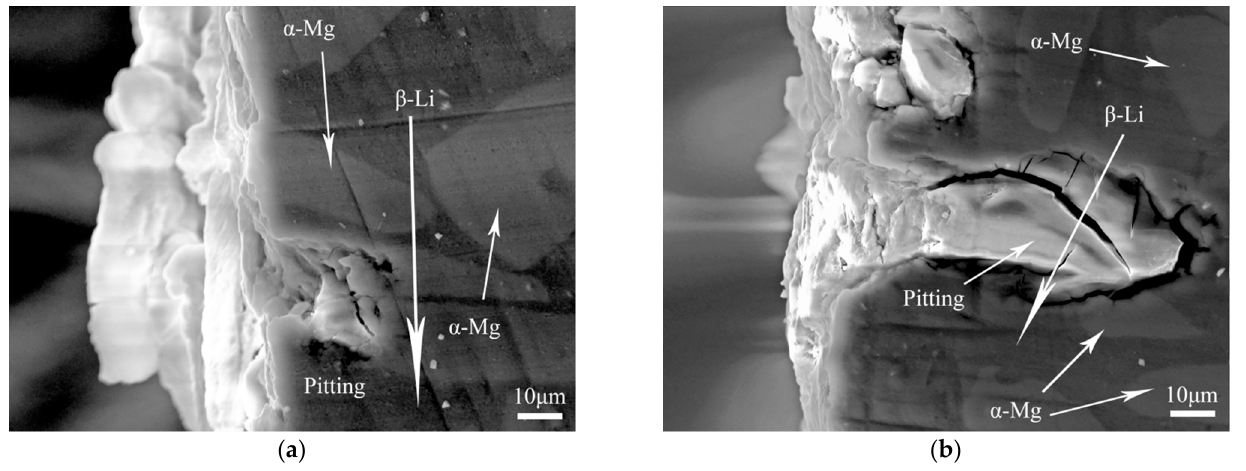
Figure 7. Cross-sectional corrosion morphologies of: ( a ) C 1 and ( b ) C 2 samples after being immersed in 3.5 wt.% NaCl solution for 6 h.